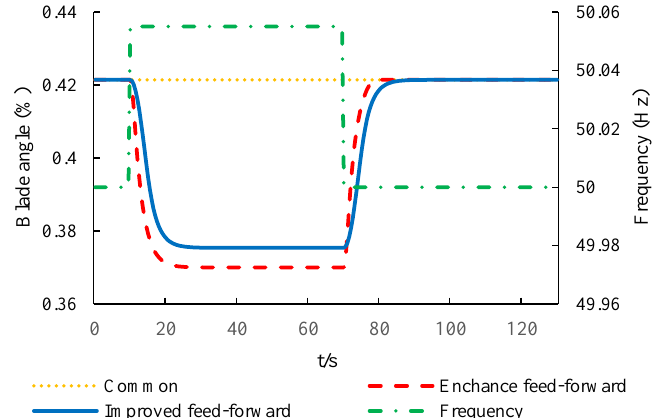
Figure 17. The guide vane opening curve of PFC with common frequency dead zone, enhanced frequency dead zone with feed-forward control, and improved frequency dead zone with feed-forward control.